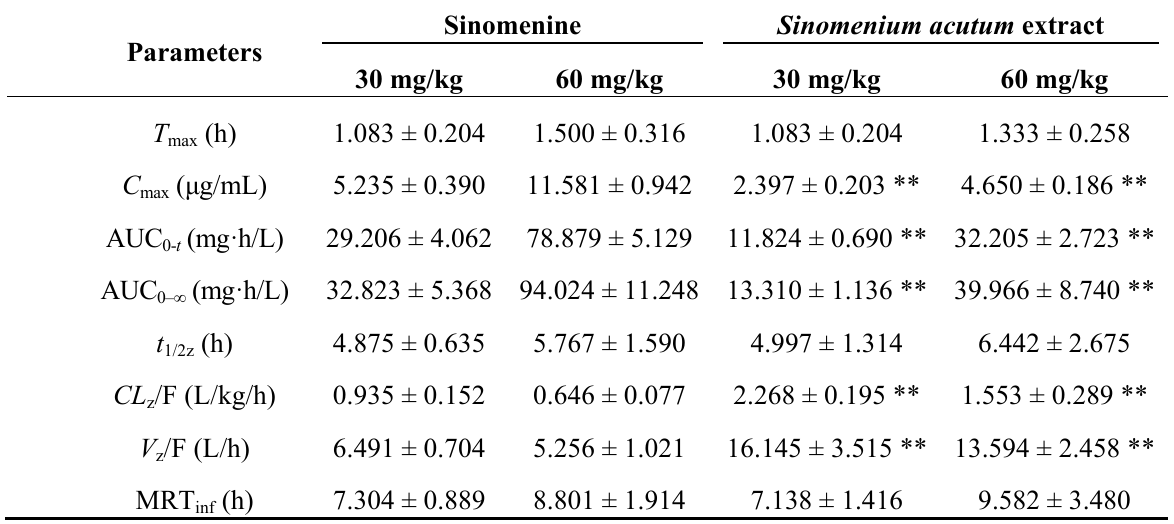
Table 2. Pharmacokinetic parameters of sinomenine in rat plasma after oral administration of sinomenine and Sinomenium acutum extract (30 and 60 mg/kg) ( n = 6).